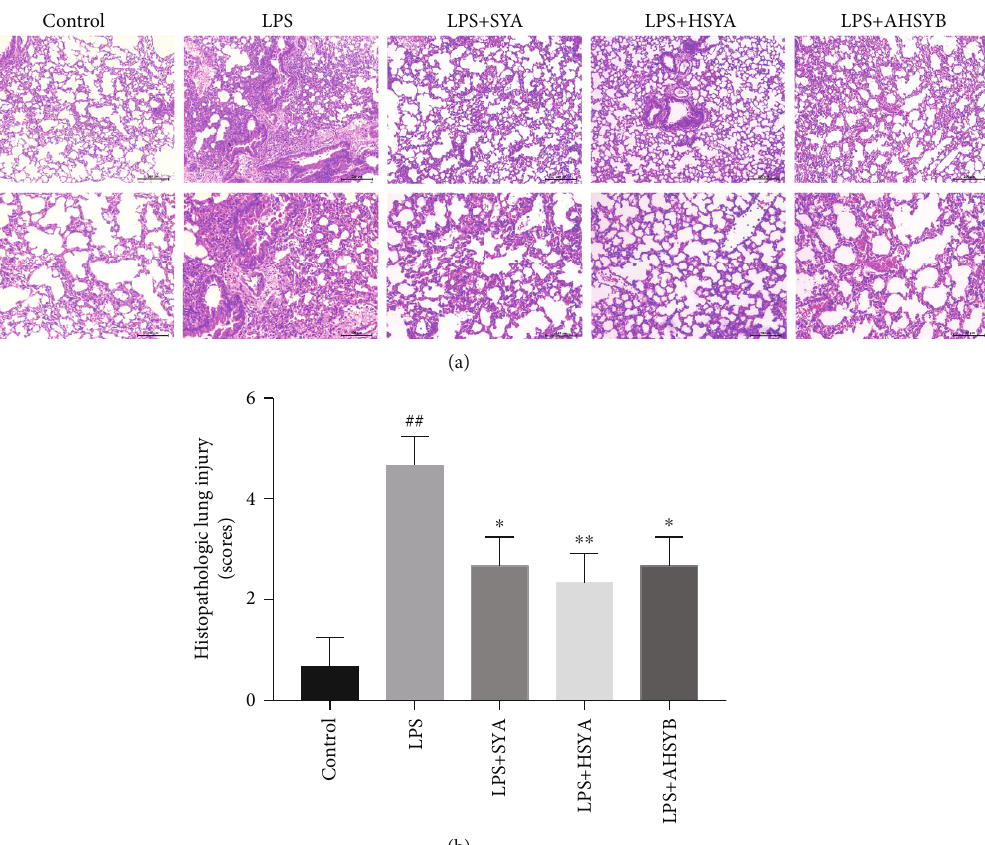
Figure 1: E ff ects of SYA, HSYA, and AHSYB on LPS-induced histopathologic changes in the lungs. (a) 24 hours after LPS injection, the lungs in each group were prepared for histological evaluation. Representative histological section of the lungs was stained by HE staining, magni fi cation (100x, bar = 200 μ m; 200x, bar = 100 μ m). (b) The lung injury scores were determined. The values presented are mean ± SEM , ## P < 0 : 01 vs the control group; # P < 0 : 05 vs the control group; ∗ P < 0 : 05 vs the LPS group; ∗∗ P < 0 : 01 vs the LPS